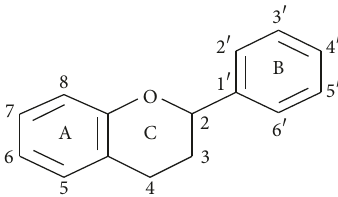
Figure 1: Basic structure of flavonoids and the system of numera- tion. A and B are phenyls, and C corresponds to pyrene. Numbers indicate the numeration system of the basic structure of flavonoids.